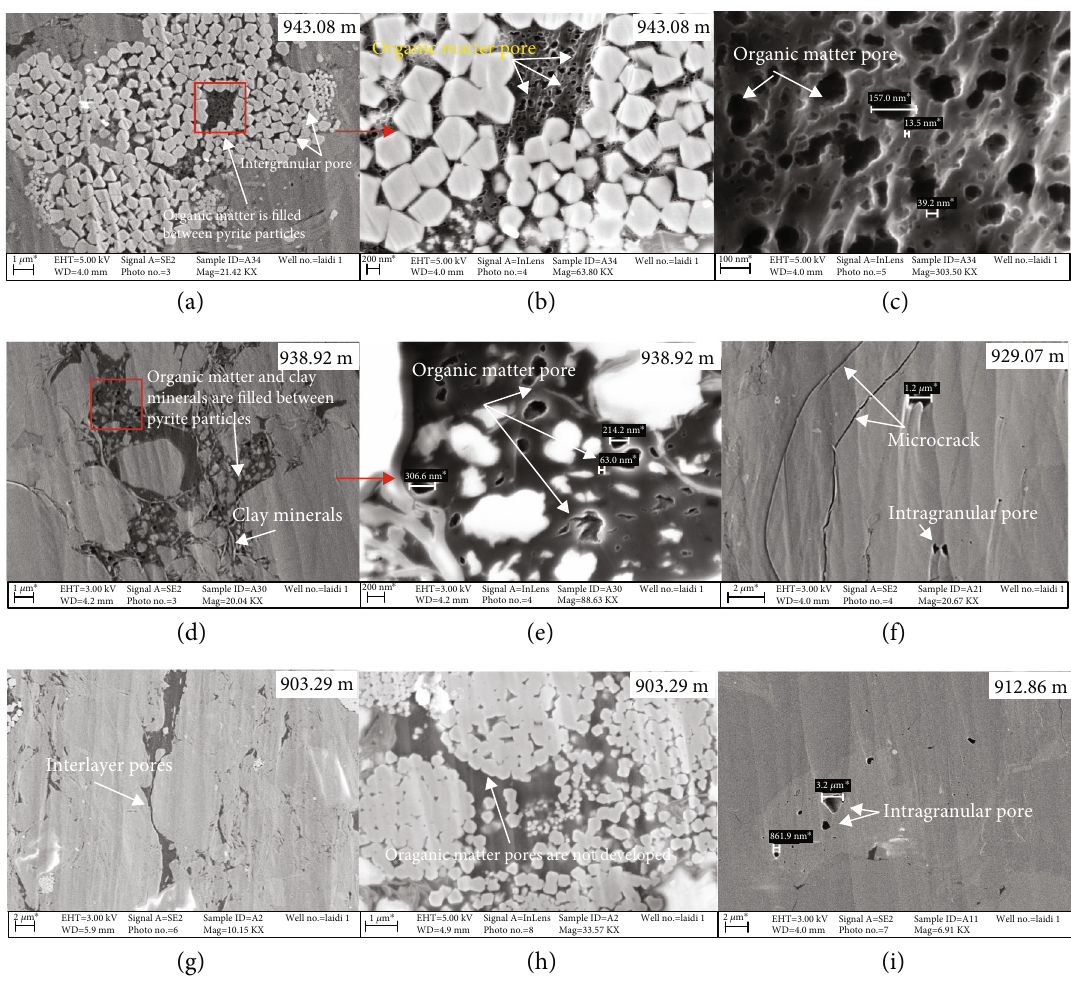
Figure 5: Pore distribution and morphological characteristics of